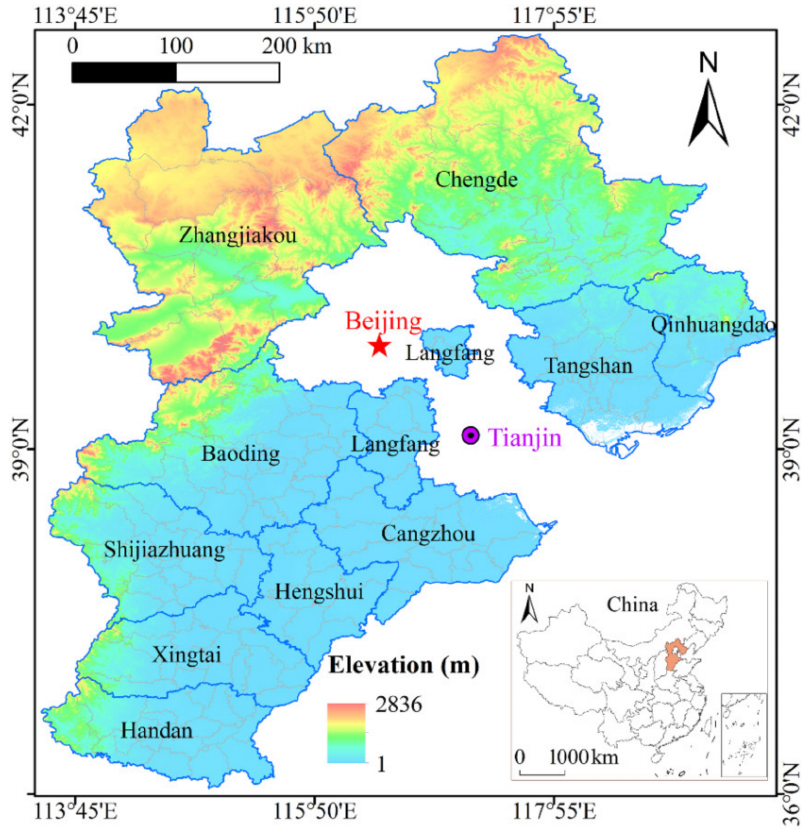
Figure 1. Location map of the study